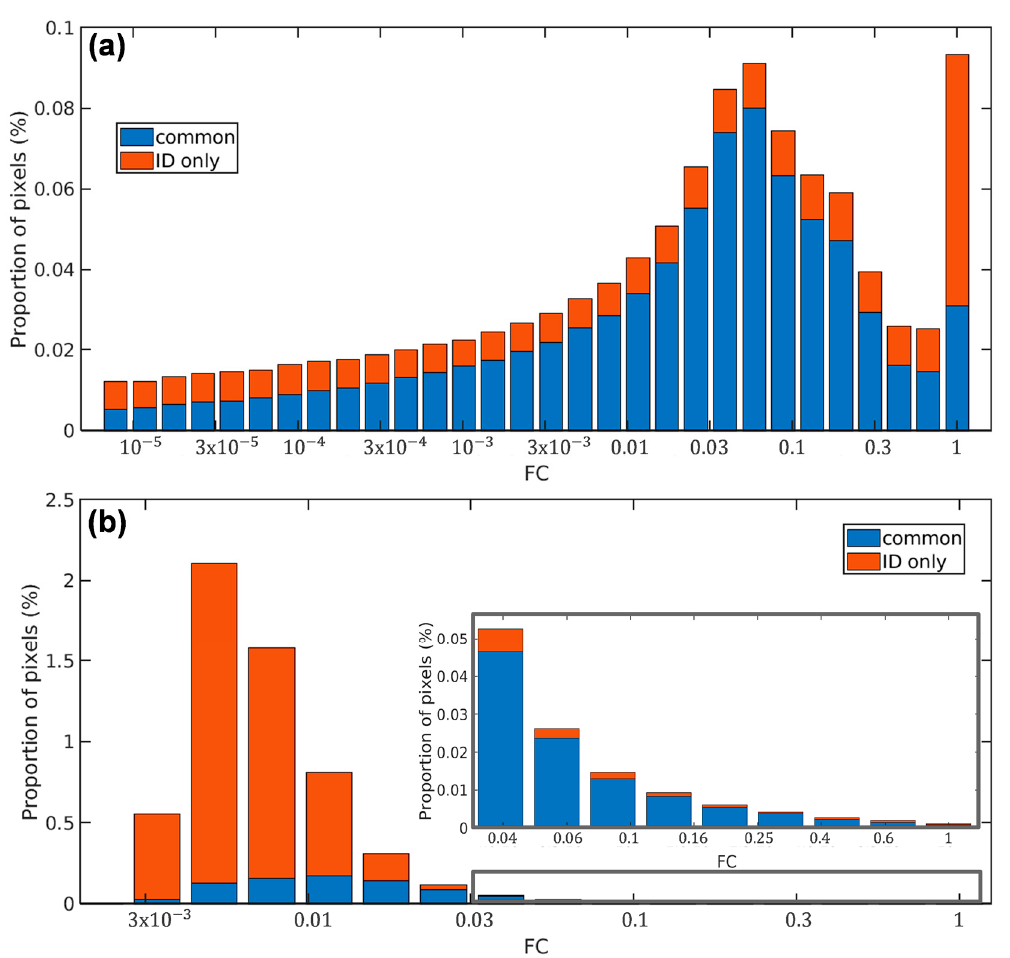
Figure 7. Distribution of the proportion of Sargassum pixels detected by both the CNN and the ID methods (blue) and detected by the ID method but not the CNN (red) for ( a ) OLCI; and ( b ) MSI. Regarding MSI, the proportion of common detection depends on the FC (Figure 7b), 35% of the FC detected by the ID method was also detected by CNN. Indeed, only few IDs were detected by the CNN with low FC (Figure 8). Less than 10% of pixels by the ID method were detected as Sargassum pixels by the CNN under a Sargassum coverage of 0.006 (2.4 m 2 /pixel). However, this proportion increased with the FC. This detection ability follows a Gompertz curve represented by Equation (9) and shown in Figure 8. About 90% of FC pixels above 0.026 (10.4 m 2 /pixel) were detected. This curve allows the expected accuracy of Sargassum detections to be predicted using the CNN method as a function of FC. where b = − 170, c = 4.6, d = 97 and e = 1.25 × 10 − 2 .